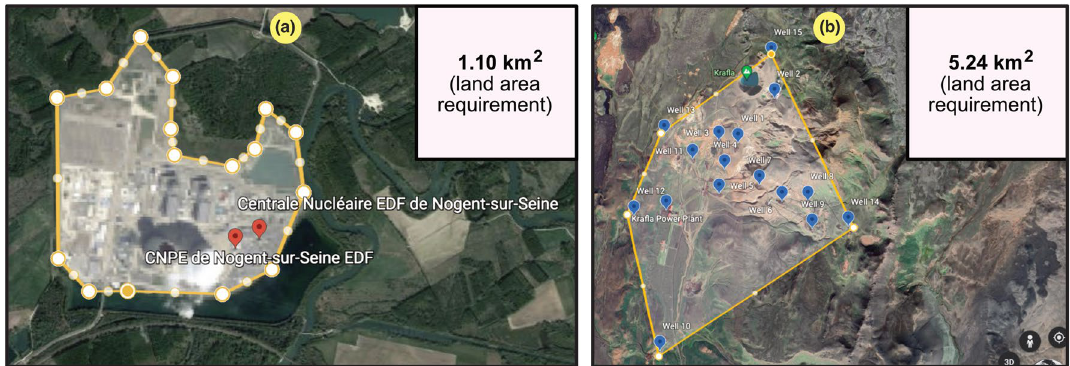
Figure 1. Example cases of the use of the Google Earth Engine 25 , version 7.3.2.5776 (https:// earth. google.